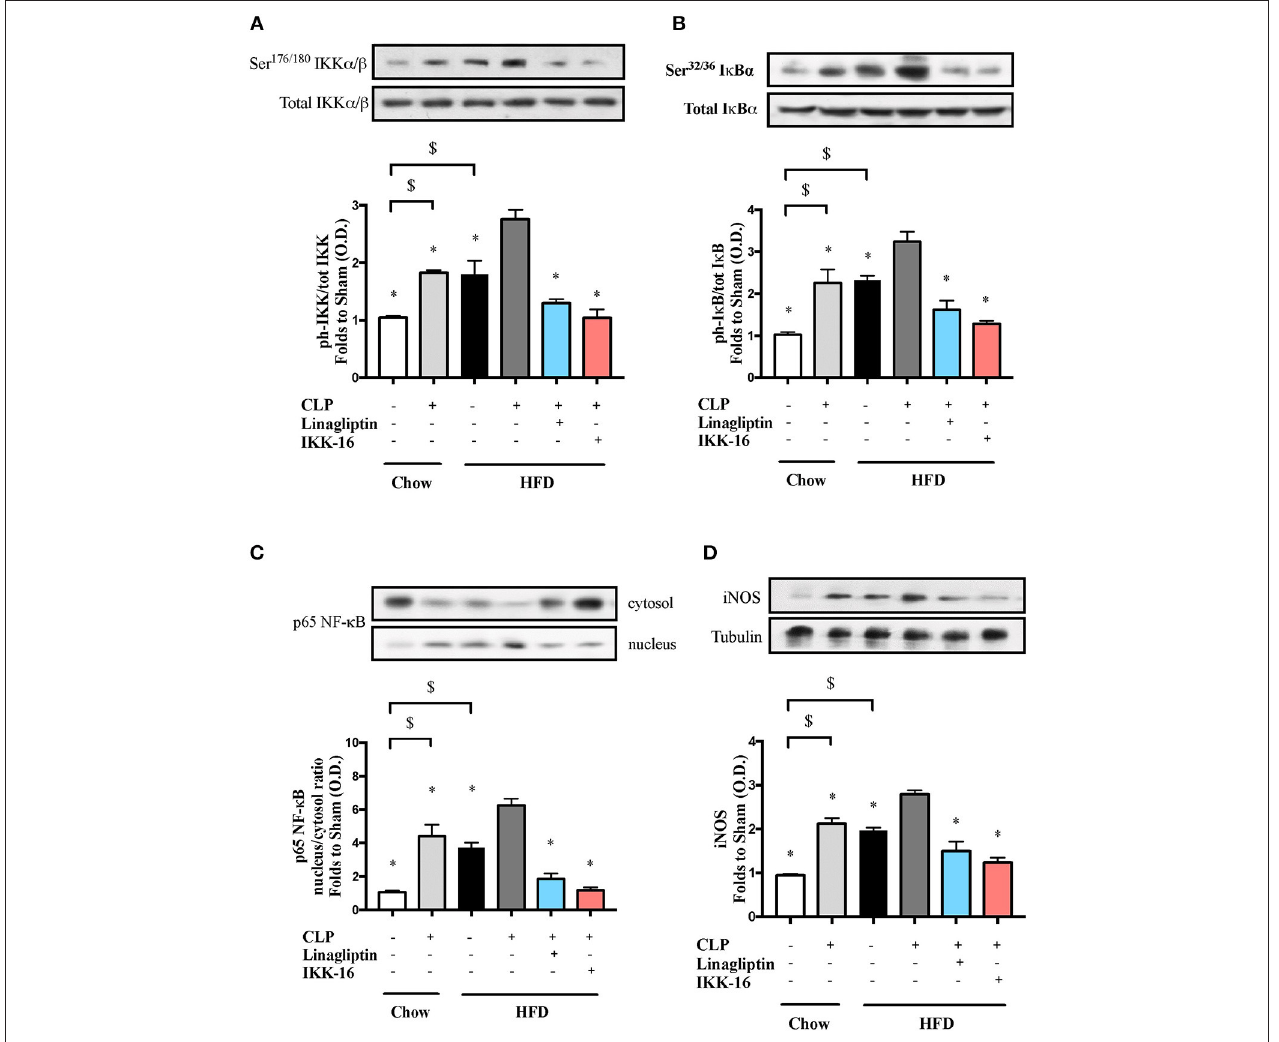
FIGURE 2 | Effects of CLP and linagliptin or IKK-16 post treatment on NF- κ B signaling pathway in the heart of mice with pre-existing T2DM . Mice from chow and HFD groups were randomized to undergo CLP or sham surgery. At 1h after CLP, mice on HFD were randomized to receive linagliptin (10 mg/kg i.v.), IKK-16 (1 mg/kg i.v.), or vehicle (2% DMSO, 3 ml/kg). At 24h heart samples were collected and signaling events were assessed. Densitometry analysis of the bands is expressed as relative optical density (O.D.) of (A) IKK α / β phosphorylation on Ser 178 / 180 corrected to the corresponding total IKK α / β content and normalized using the related sham band; (B) I κ B α phosphorylation on Ser 32 / 36 corrected to the corresponding total I κ B α content and normalized using the related sham band; (C) NF- κ B p65 subunit levels in both, cytosolic and nuclear fractions expressed as a nucleus/cytosol ratio normalized using the related sham bands; (D) inducible nitric oxide synthase (iNOS) expression corrected for the corresponding tubulin band and normalized using the related sham band. Data was analyzed using one-way ANOVA followed by Bonferroni’s post-hoc test and expressed as mean ± SEM.* P < 0.05 compared to HFD + CLP group, $ P < 0.05. ( n = 4–6 per